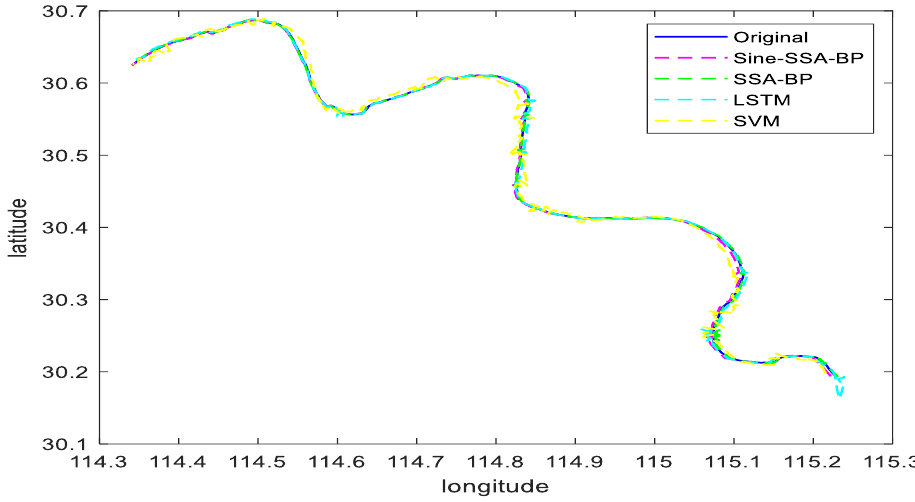
Figure 15 . Comparison of trajectory prediction of different models in Scenario 2.